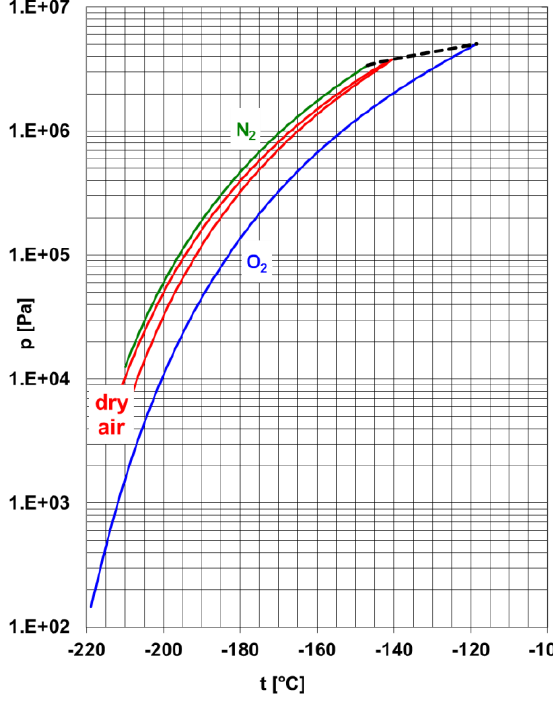
Fig. 3. Liquid-vapor saturation curve in the phase p t  diagram for the dry air (red loop), nitrogen N (green curve) 2 and oxygen O (blue curve); pseudocritical states of the 2 mixture of nitrogen N and oxygen O - black dotted 2 2 O - blue; N - green, oxygen 2 2